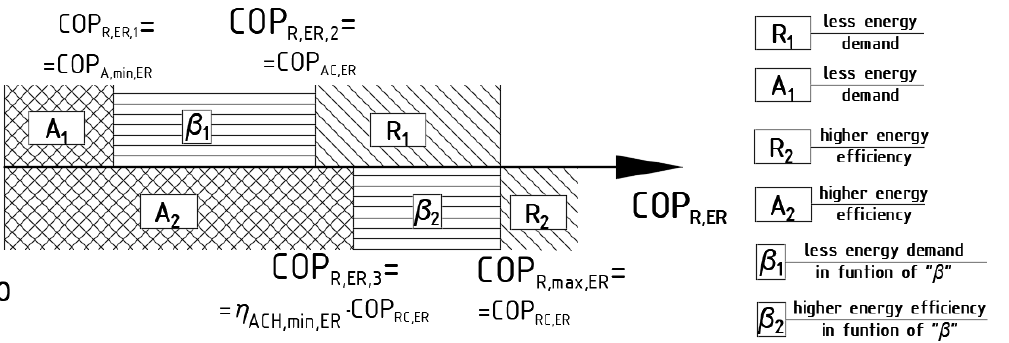
Figure 2. Energy demand and energy efficiency as a function of the coefficient of performance.